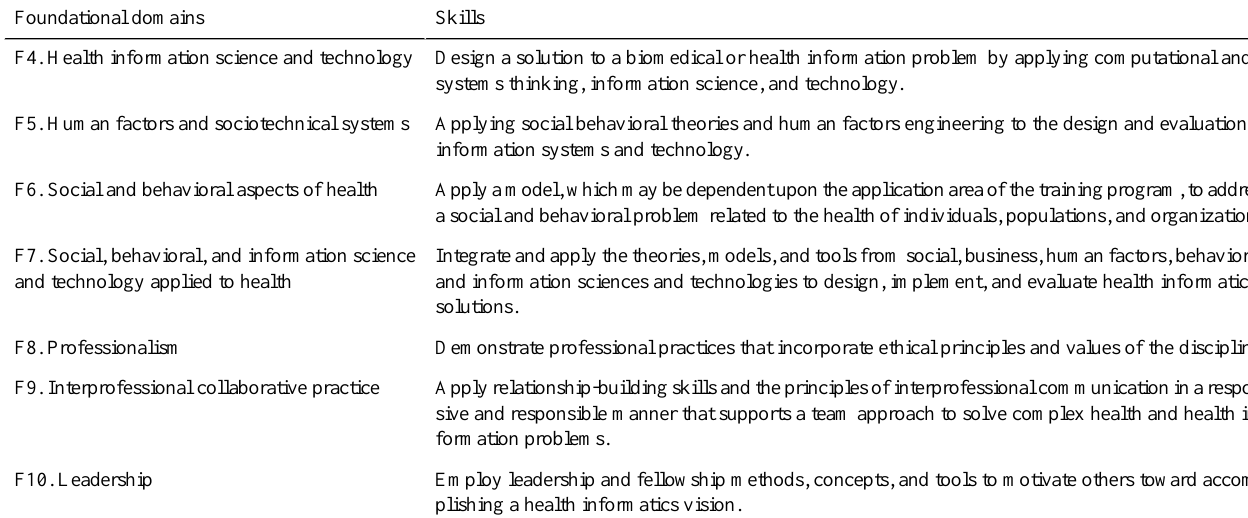
Table 2. The Commission on Accreditation for Health Informatics and Information Management Education’s revised health informatics skills according to the American Medical Informatics Association 2017 core